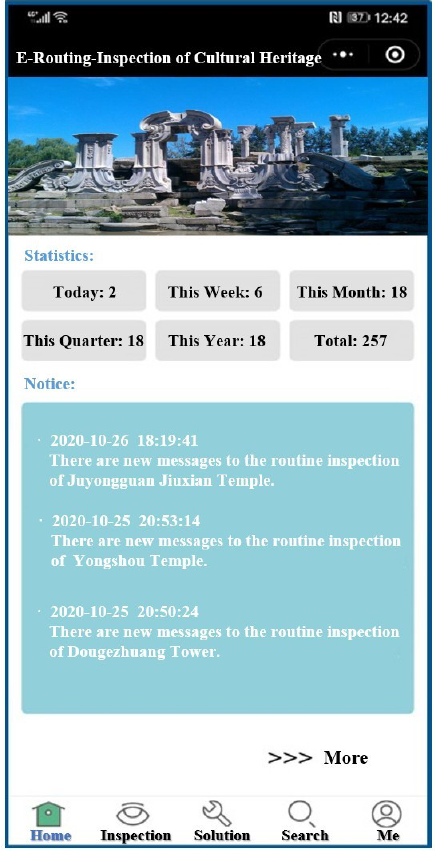
Figure 8: E-routing-inspection of cultural